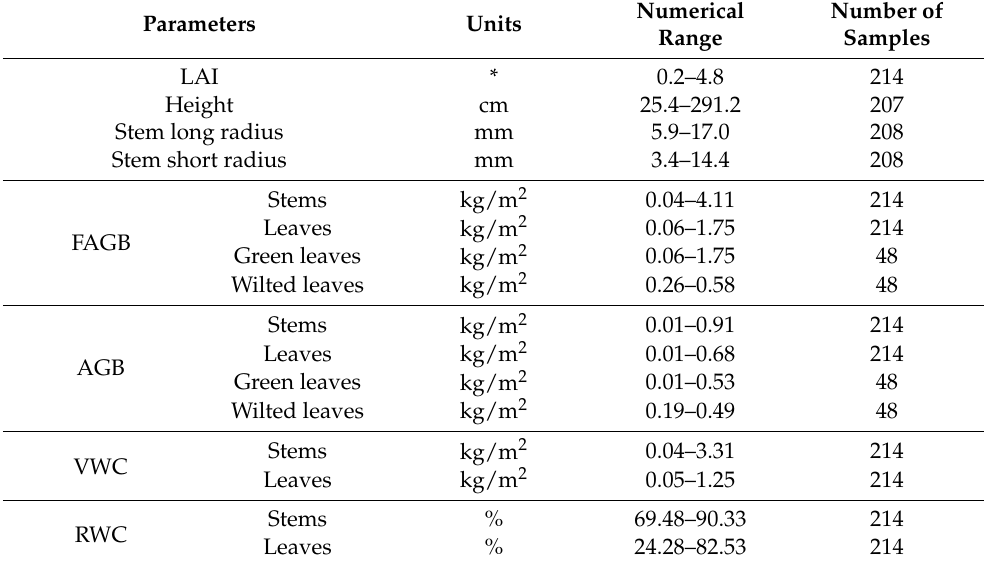
Table 1. The canopy parameter observation datasets for the entire maize growing season in 2021. Parameters Units